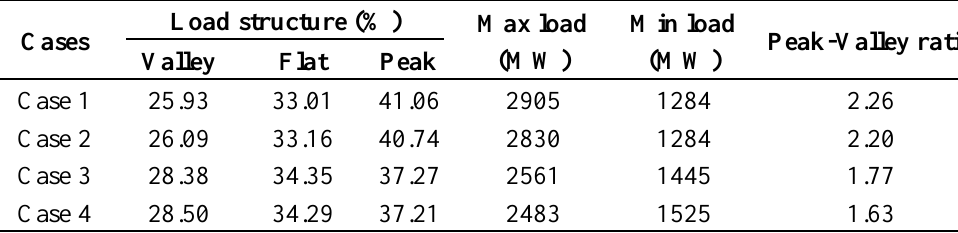
Table 3. Load demand structure in four